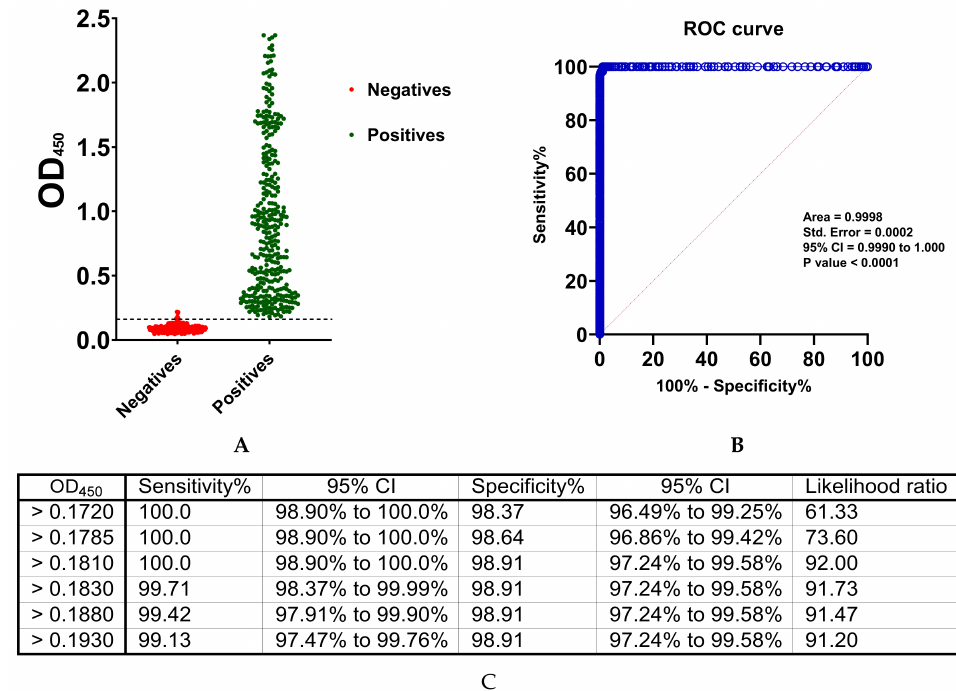
Figure 3. Receiver operating characteristics (ROC) analysis. ( A ) Data utilized for ROC analysis. ( B ) ROC curve. ( C ) A range of cut-off values with their associated sensitivity, specificity, and 95% confidence interval (CI) are